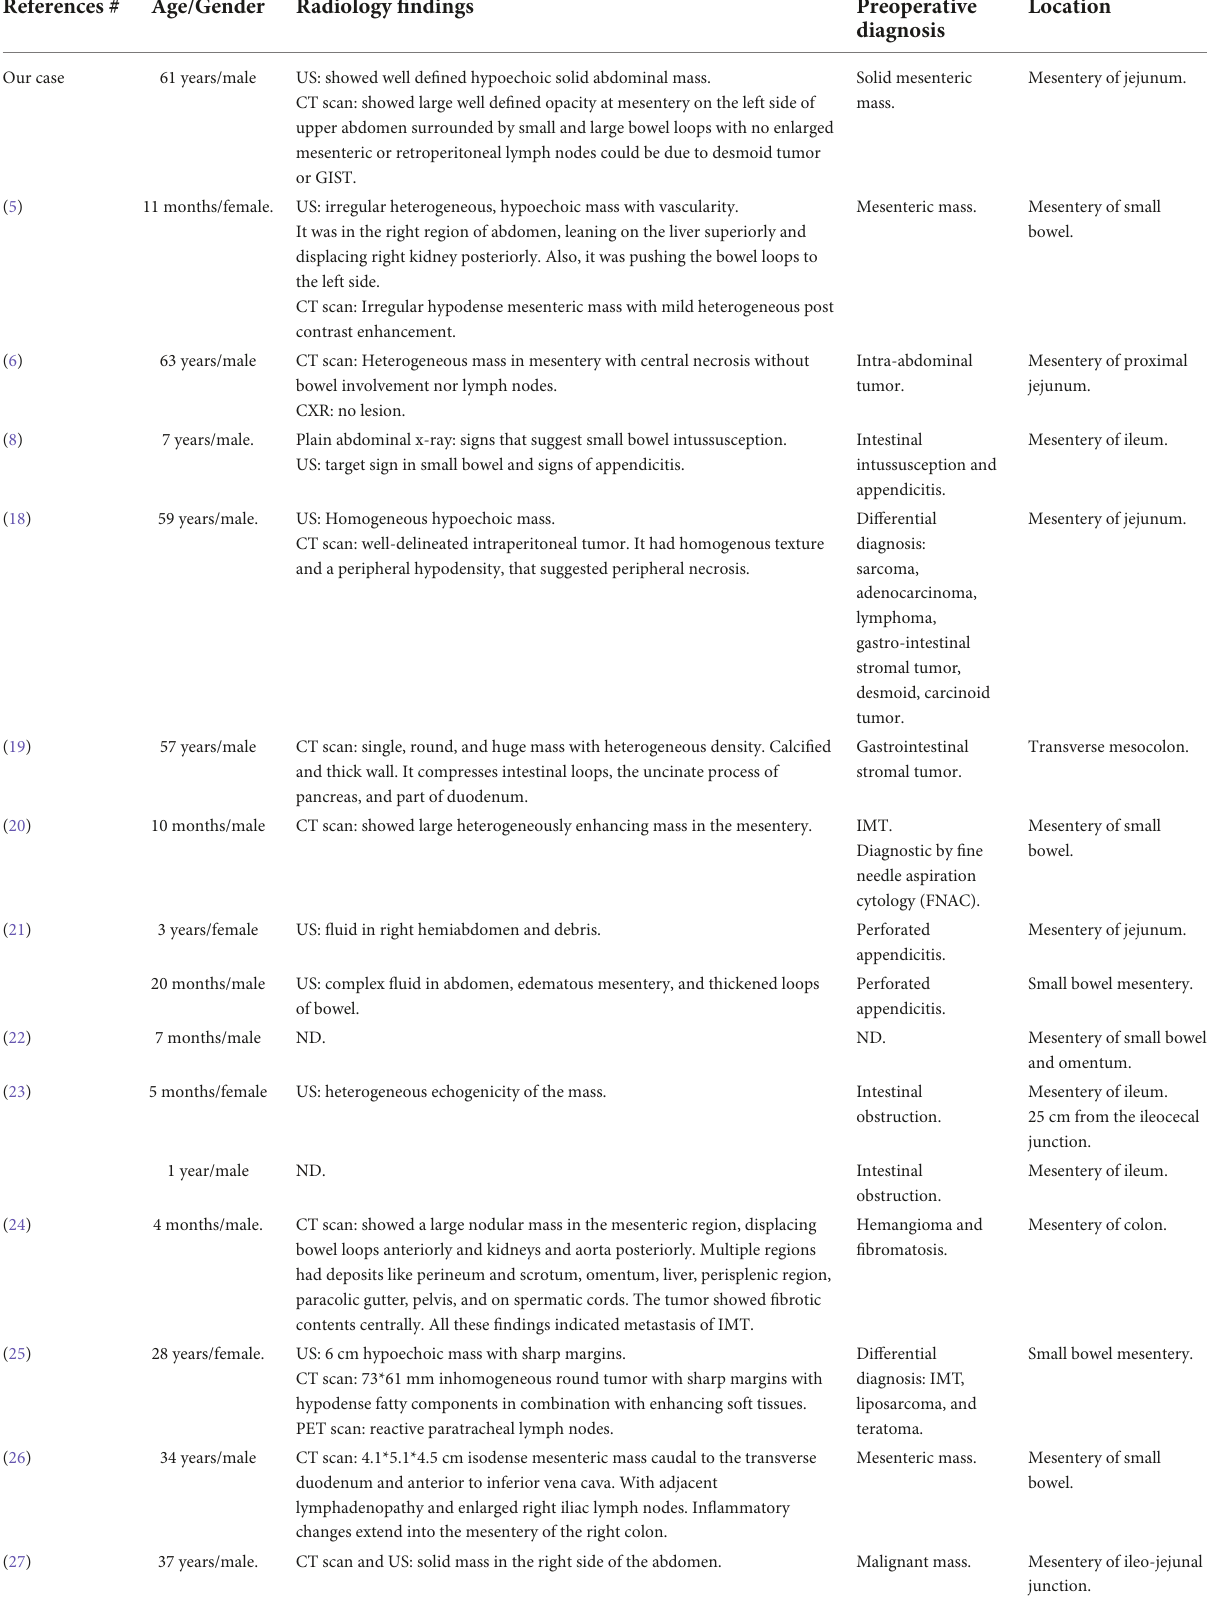
TABLE 2 Radiological features of the reported cases of inflammatory myofibroblastic tumor of the